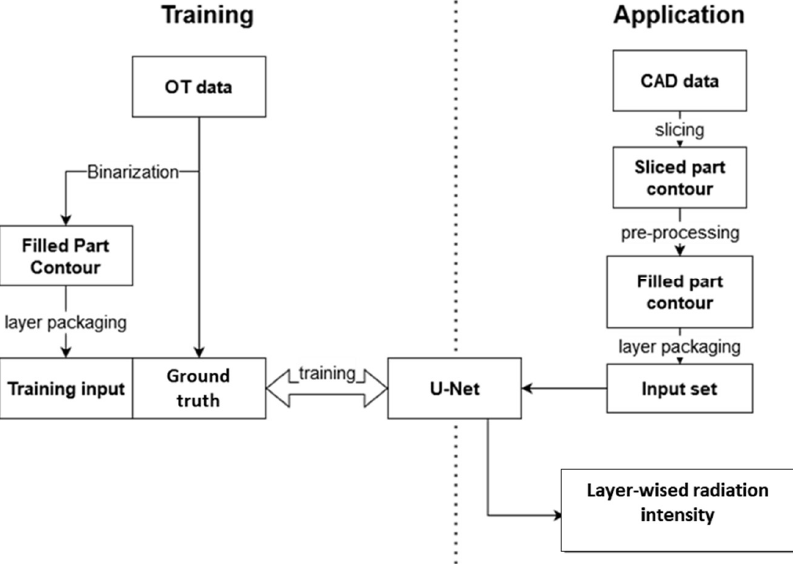
Figure 1. Framework for the prediction of the radiation.